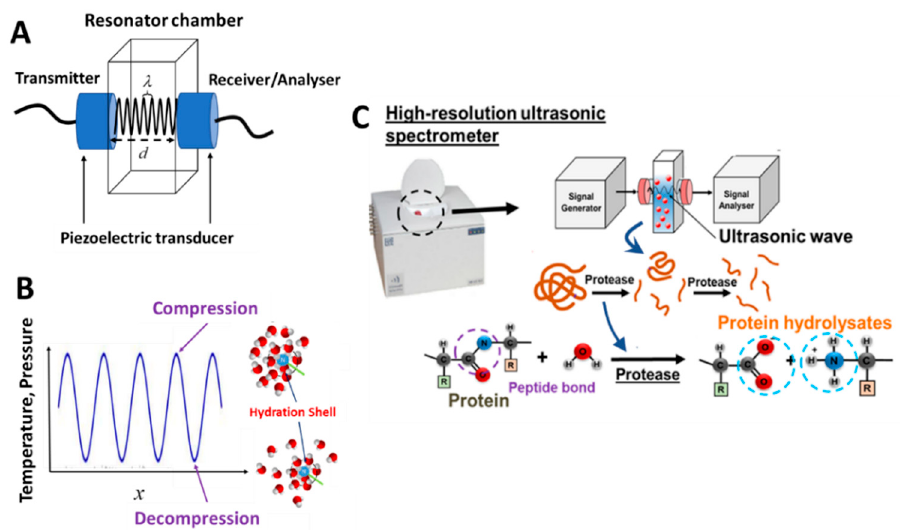
Figure 8. ( A ) Ultrasonic measuring system using an ultrasonic resonator system. ( B ) The ultrasonic wave propagation induces the oscillation of temperature or pressure, which results in the compression and decompression of water molecules within the hydration shell surrounding the terminal α -amino group. ( C ) Overall scheme of the peptide bond hydrolysis and high-resolution ultrasonic spectroscopy (HR-US) measuring principles.